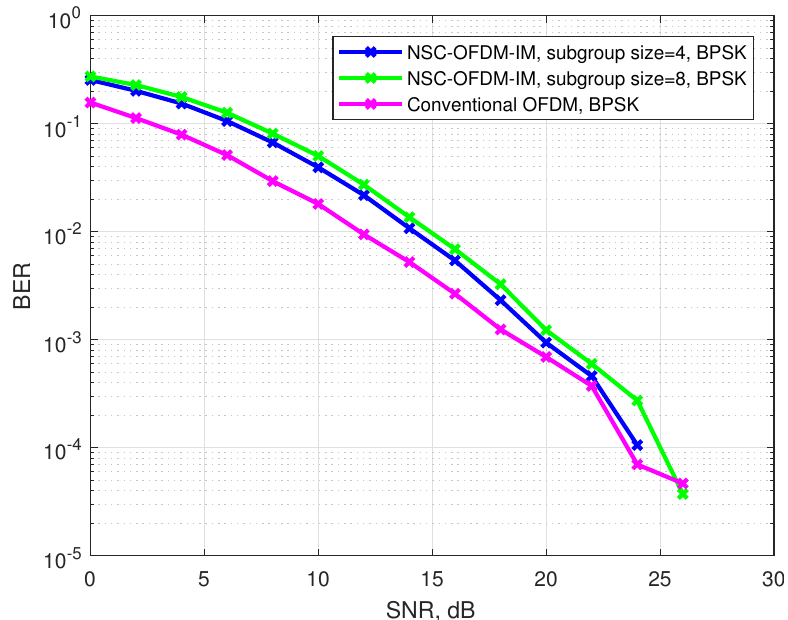
Figure 15. Performance of the proposed NSC-OFDM-IM without applying the LLR